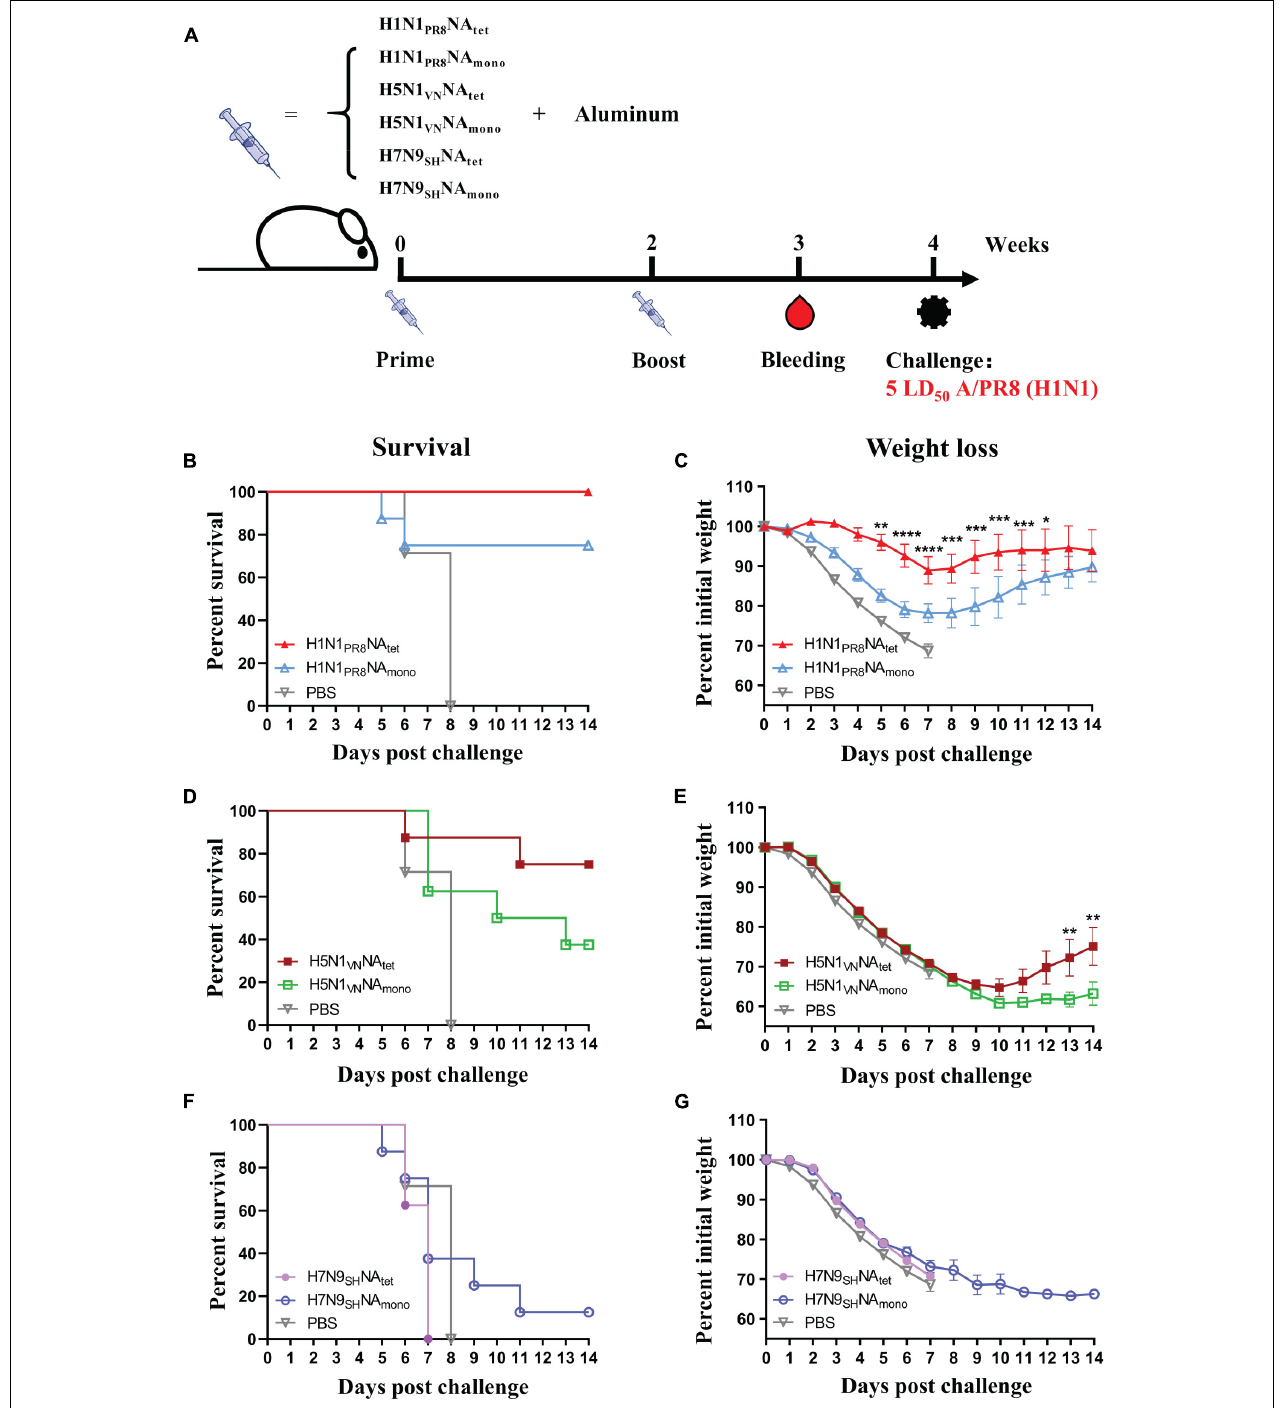
FIGURE 2 | Protective efficacy of tetrameric neuraminidase (NA) vs. monomeric NA. (A) The experimental design for immunization and challenge studies. Six- to eight-week-old BALB/c mice ( n = 8 in each group) were immunized twice at 2-week interval with 20 µ g of H1N1 PR 8 NA tet , H5N1 VN NA tet , H7N9 SH NA tet , H1N1 PR 8 NA mono , H5N1 VN NA mono , and H7N9 SH NA mono proteins adjuvanted with aluminum (i.p.), respectively. Sera were collected at 1 week after the final immunization; then, the mice were challenged with 5 LD 50 of A/PR8 (H1N1) virus intranasally (i.n.) at 2 weeks after the final immunization. (B–G) Survival rates (B,D,F) and weight loss (C,E,G) were monitored for 14 days post-infection.